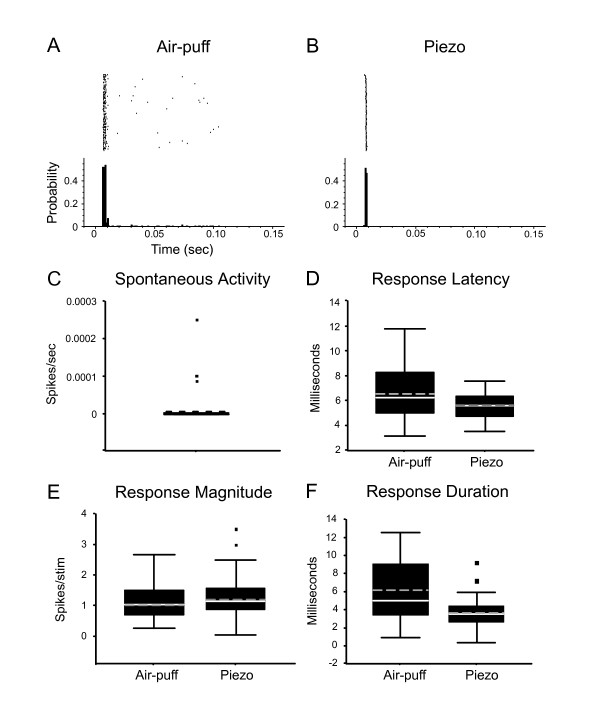
Response kinetics of superior colliculus neurons. A-C: PSTHs of representative responses constructed with 1 msec bins. Collicular responses to air-puffs (A) or piezoelectric (B, piezo) vibrissa deflections. C-F: Boxplots depict median (solid line), mean (dotted line) and 1st and 3rd quartiles (box). Whiskers represent data within 1.5 times the range from the 1st to the 3rd quartile. Squares represent outliers (data outside 1.5 times the range from the 1st to the 3rd quartile). C: Neurons in the superior colliculus have low or no spontaneous activity. D: Response latencies evoked by air-puff deflections were not significantly different than those evoked by piezoelectric deflections (P = 0.2). E: Response magnitude was unaffected by stimulus type (P = 0.7). F: Response durations were short and unaffected by stimulus type (P = 0.07). All statistical comparisons use the Kolmogorov-Smirnov test.